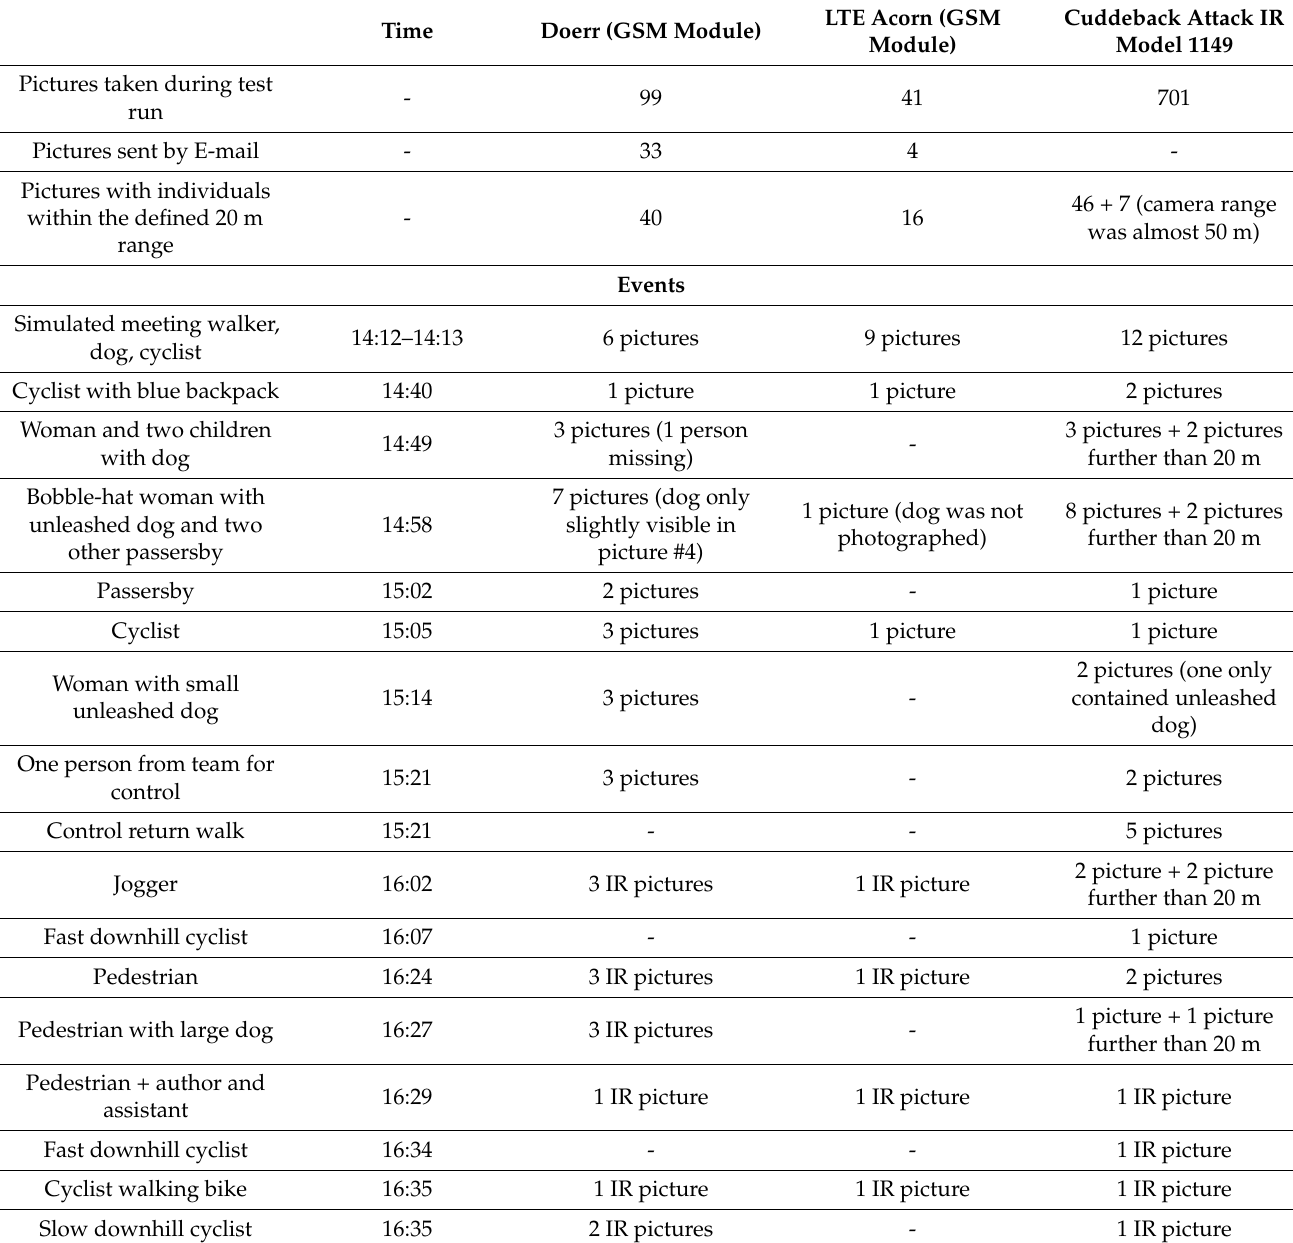
Table A2. Results of the test run with selected cameras, conducted 2 December 2014, 14:10–16:50 in windy